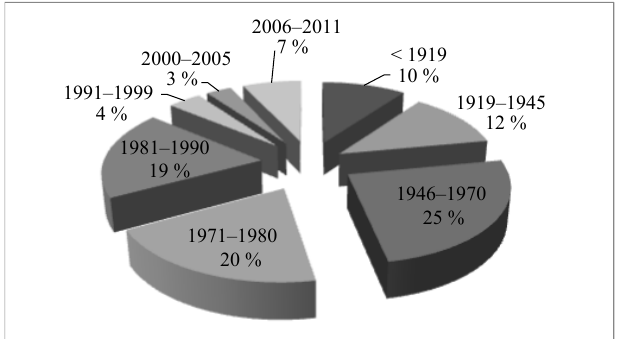
Fig. 1. Age distribution of the housing stock in Latvia, % (Brick & Smiles Property Brokers, 2012) [Figure made by the